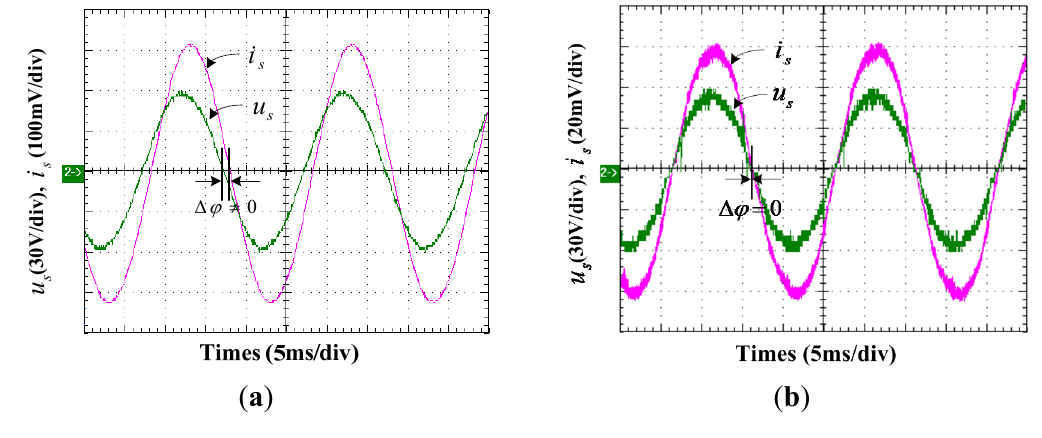
Figure 17. The voltage and current in reactive power compensation mode. ( a ) Before compensation; ( b ) After